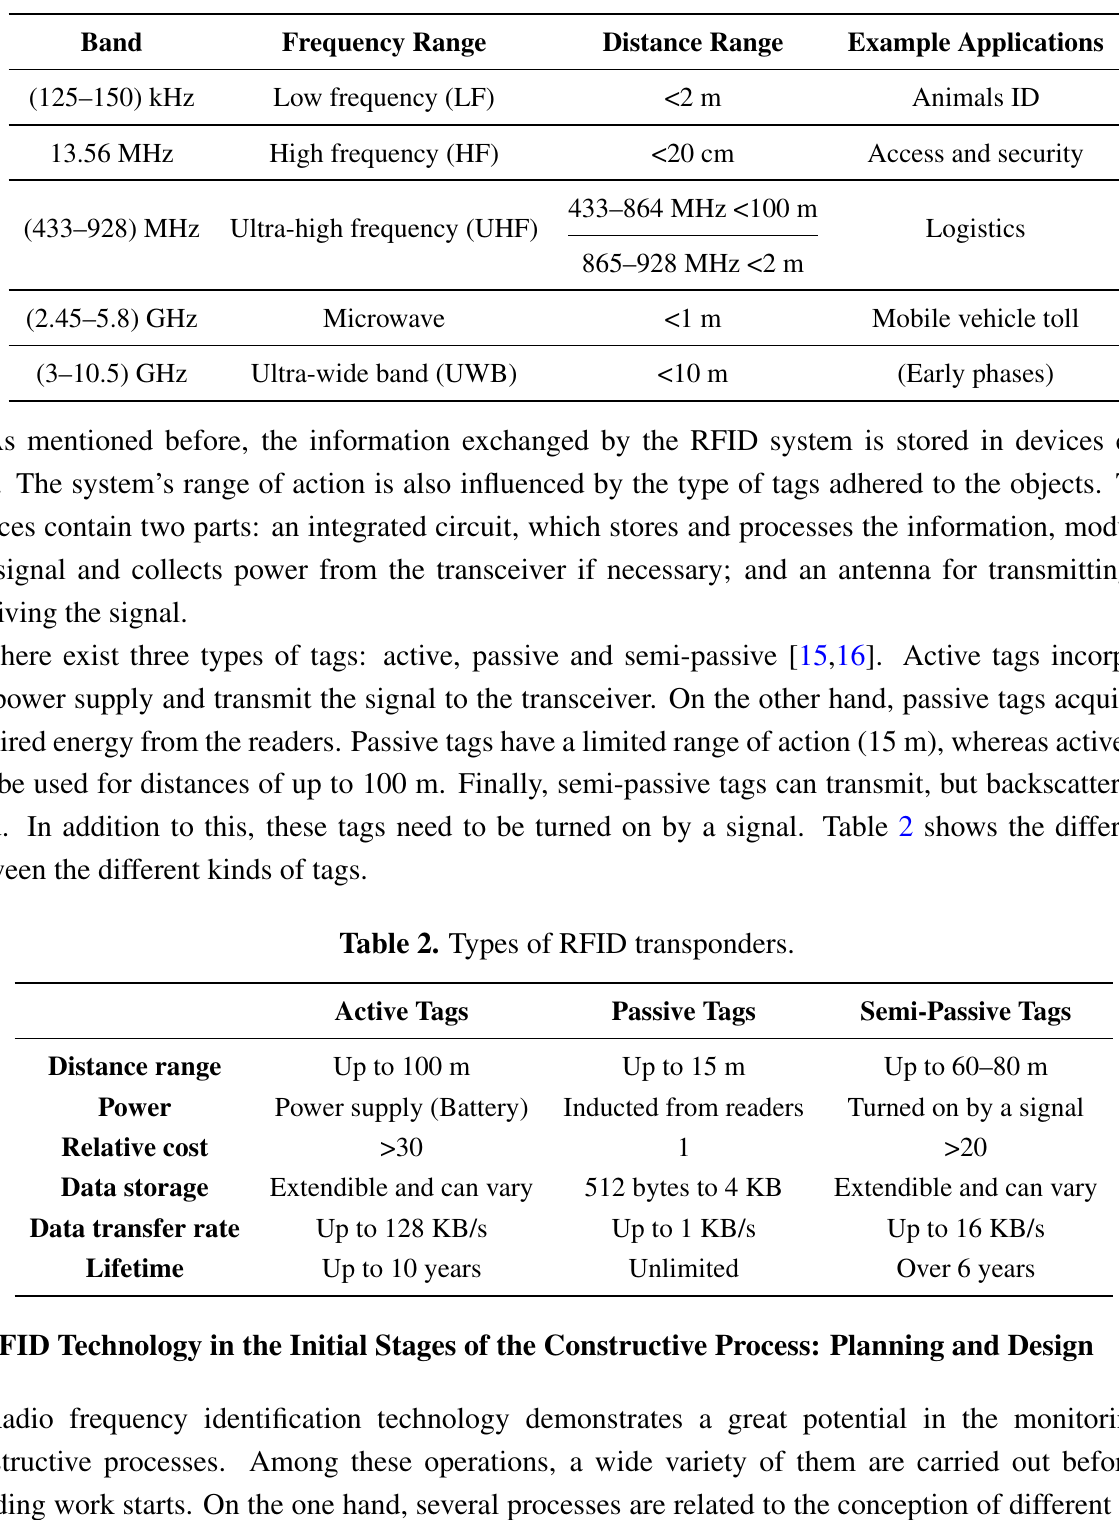
Table 1. Operation bands for RFID technologies.